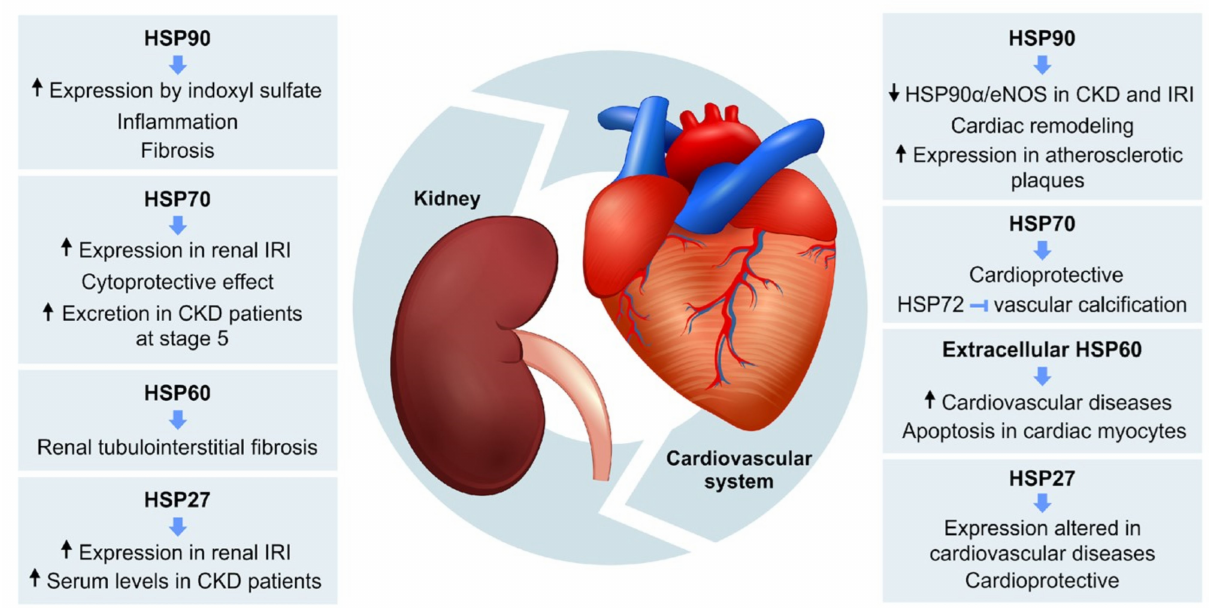
Figure 2. Schematic model showing the main role of HSPs in renal and cardiovascular diseases. HSP90, HSP70, HSP60 and HSP27 participate in pathophysiological mechanisms of renal and cardiovascular disorders, including the relationship between them in cardiorenal syndrome. HSP: heat shock proteins; CKD: chronic kidney disease; IRI: ischemia and reperfusion injury; eNOS: endothelial nitric oxide